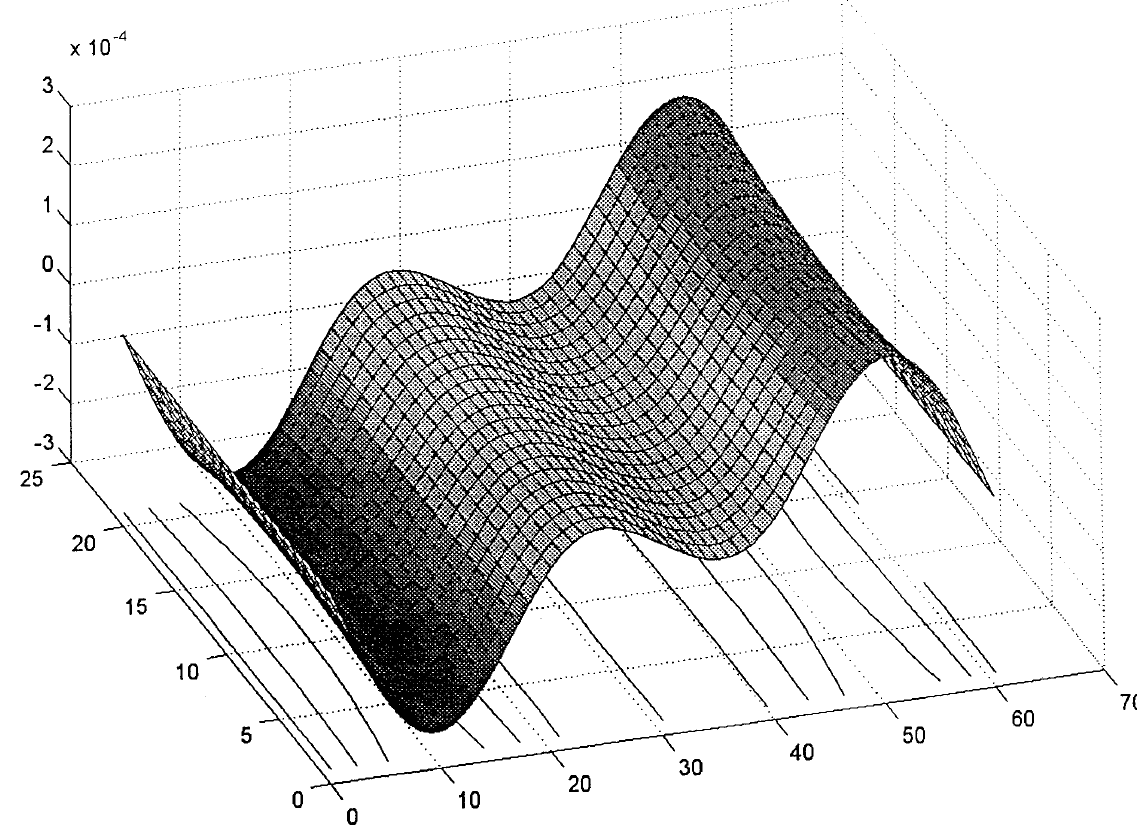
Fig. 7. Second mode shape of 3-span deck, φ 1 = φ 3 = 1 . 0 , φ 2 = 1 . 1